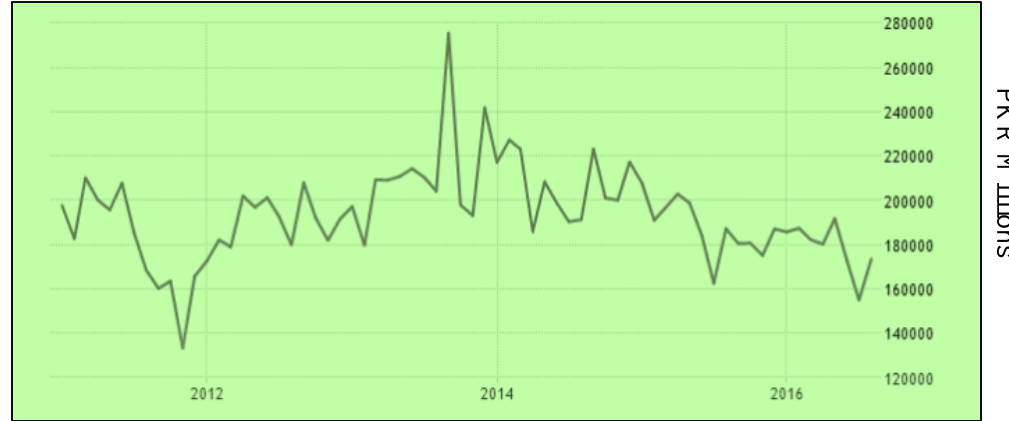
Figure 1. Pakistan’s textile industry exports. Source: Pakistan Bureau of Statistics (2016).